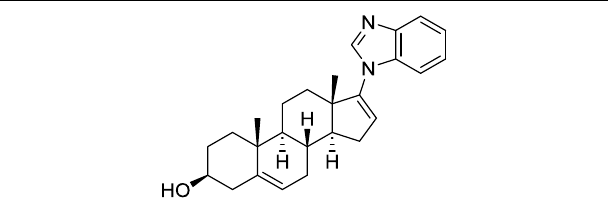
FIGURE 3 | Structure of galeterone.